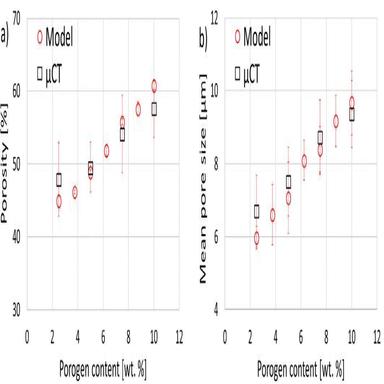
The dependence of porosity a) and mean pore size b) on initial porogen content. Error bars indicate ± standard deviation.